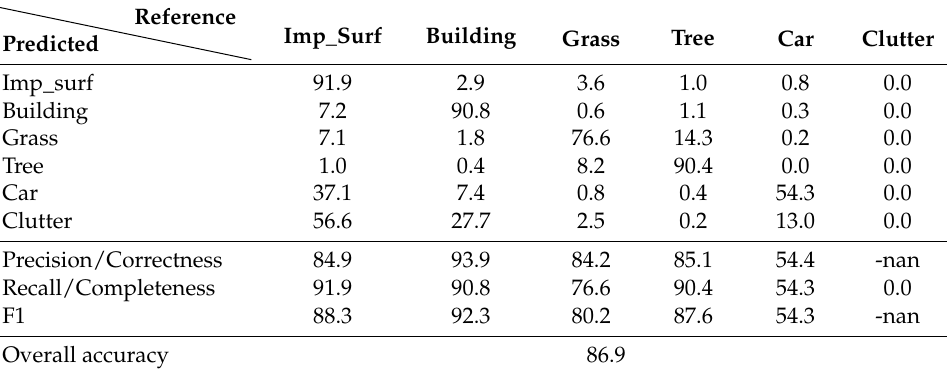
Table 4. Accumulated confusion matrix and some derived measures (precision, recall and F1 score) of the ISPRS Semantic Labeling Contest benchmark on the unseen testing